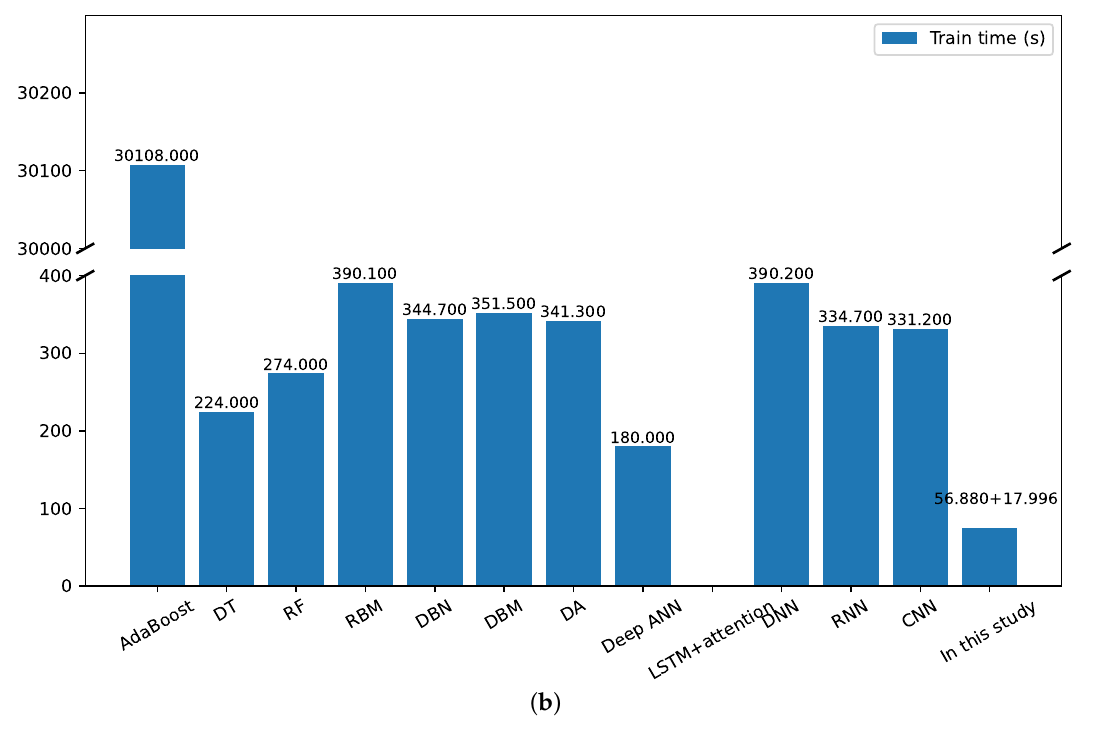
Figure 3. Comparison of the proposed model and previous studies on the CSE-CIC-IDS-2018 dataset. ( a ) classification performance; ( b ) train